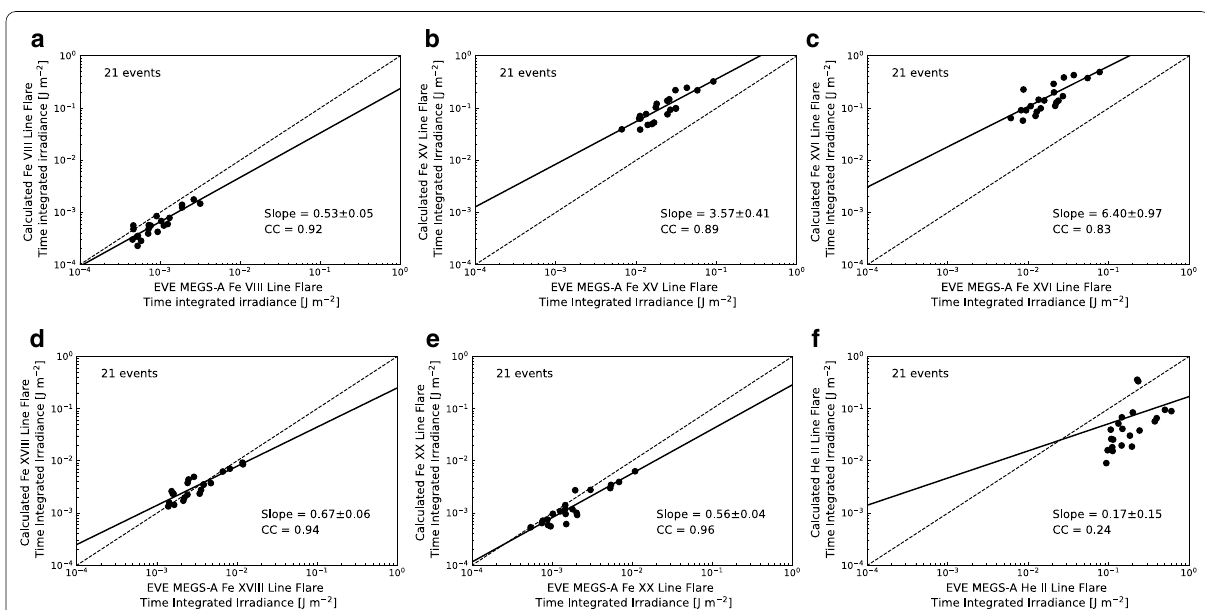
Fig. 10 Comparison results of EUV flare line time-integrated irradiance. Relationship between the SDO/EVE MEGS-A observations and the proposed model estimations of the EUV flare time-integrated irradiance for a Fe VIII, b Fe XV, c Fe XVI, d Fe XVIII, e Fe XX, and f He II. In each panel, the solid line indicates the regression of each plot; the dashed line indicates the straight line with slope of “1”. The slope of the regression and correlation coefficient (CC) are shown at the bottom